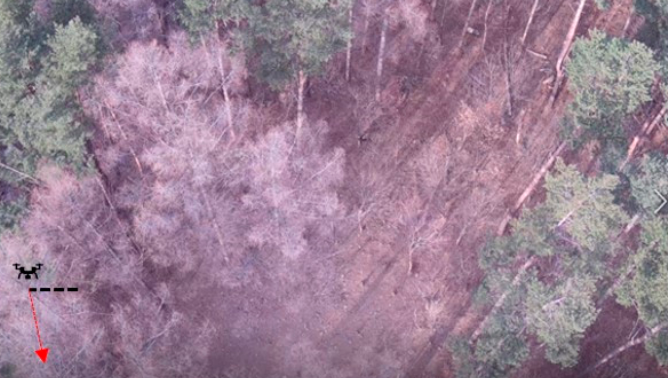
Figure 5. The monitoring screens of a portion of whole area on November 2020 using approximately 79 degrees angle.